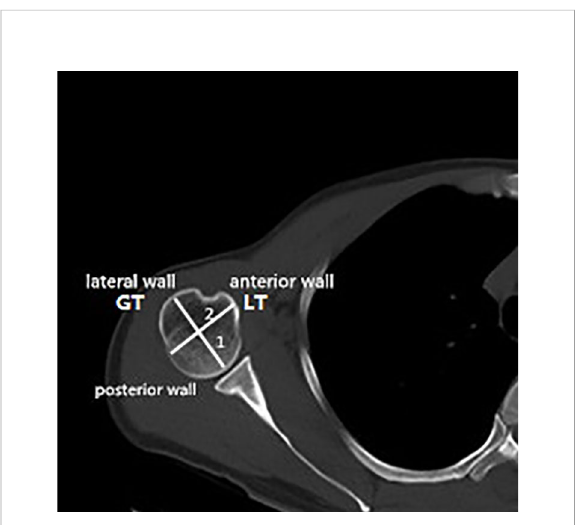
FIGURE 2 Locations of the measuring points in the humeral head region. Line 1, longest diameter between the articular surface and the greater tuberosity. Line 2, vertical bisection of line 1. GT, greater tuberosity; LT, lesser tuberosity.